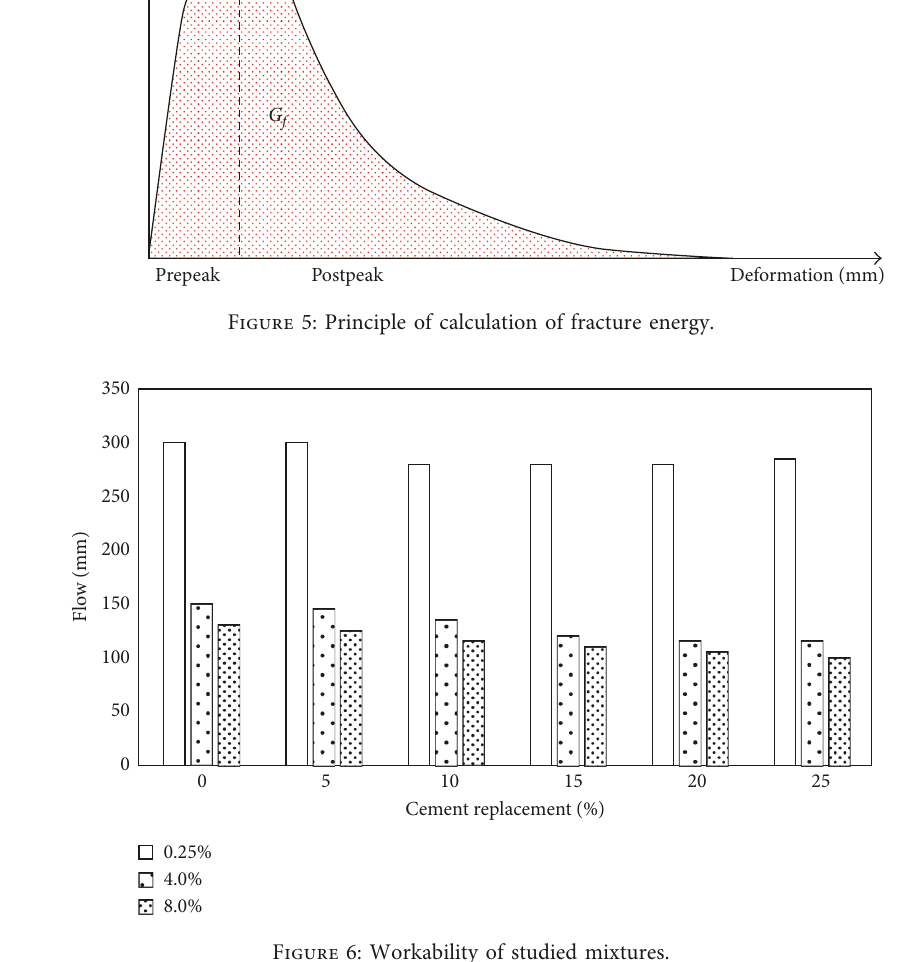
Figure 6: Workability of studied